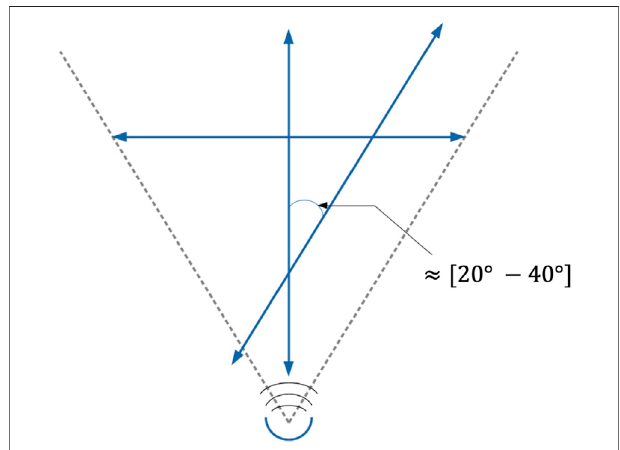
FIGURE 7 | Three directions of motion of the targets, radial, diagonal, and perpendicular.